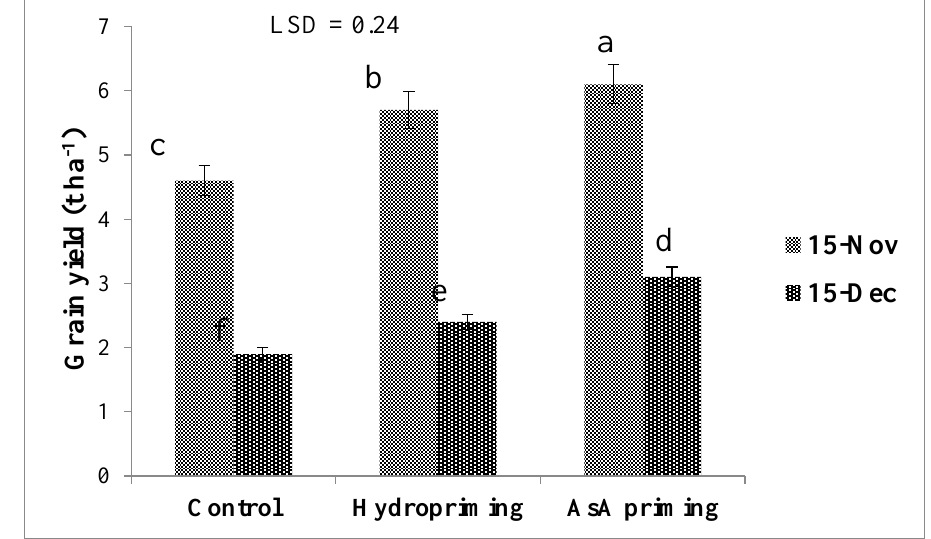
Figure 9. Interaction between priming techniques and sowing dates for grain yield during 2016. Means not sharing same letter (s) differ significantly at p ≤ 0.05.